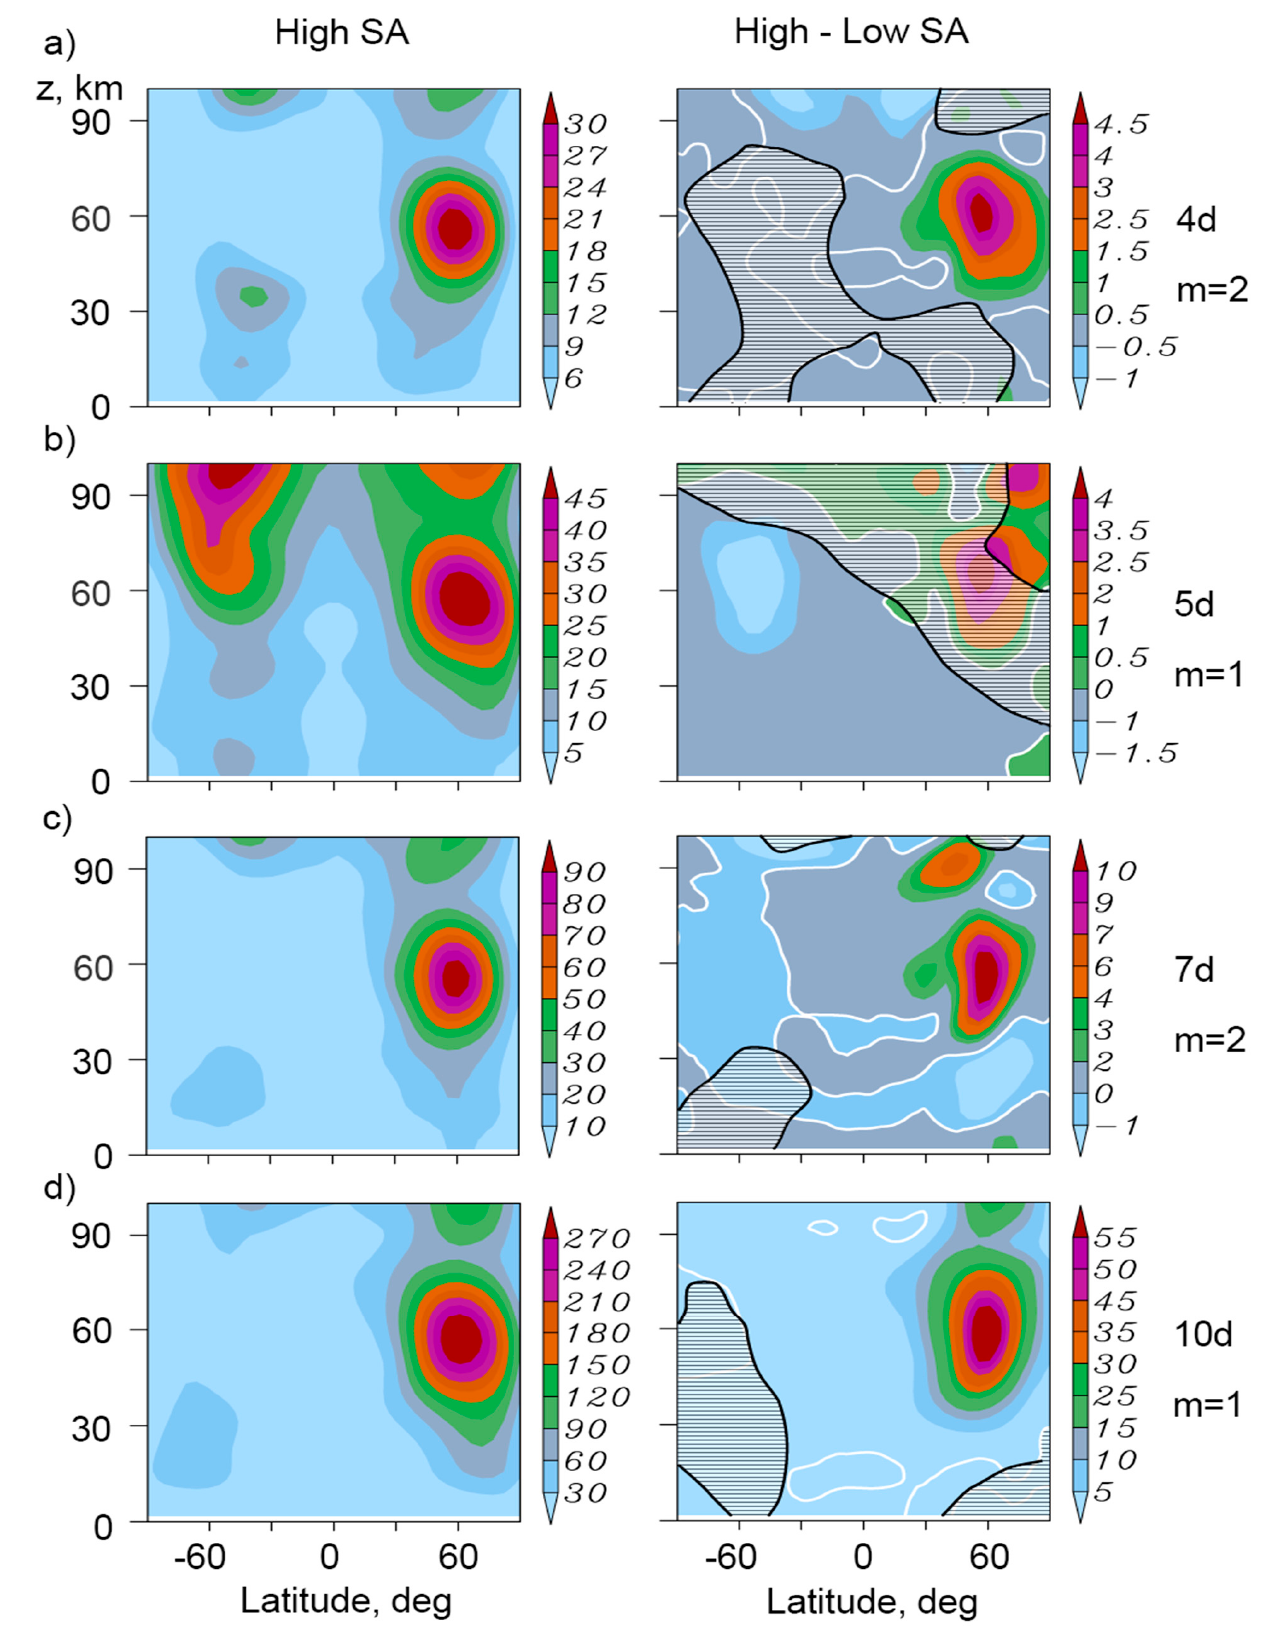
Figure 3. The same as Figure 2 but for altitude range 0–100 km. The refractivity index ( n 2 ) and Eliassen–Palm flux (EP flux) were calculated for the waves shown in Figure 2 to interpret the obtained PW differences. The theory of planetary